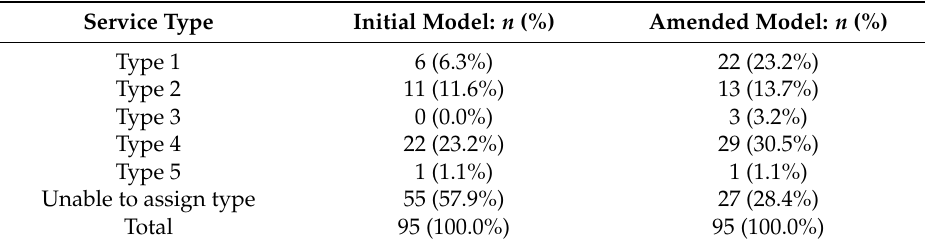
Table 3. Performance of initial and amended,